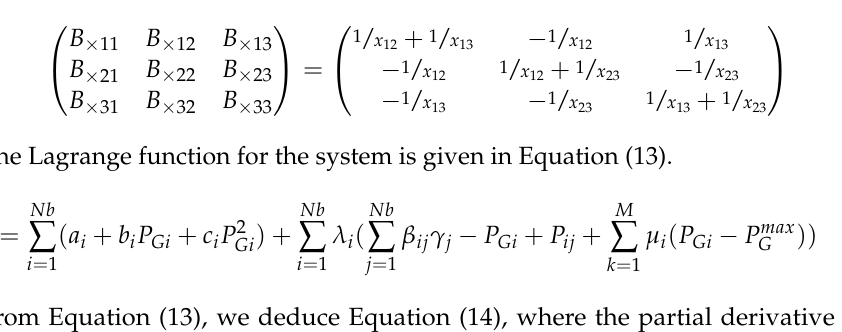
Figure 2. Three-bus power network. The network bus susceptance matrix B is defined in Equation